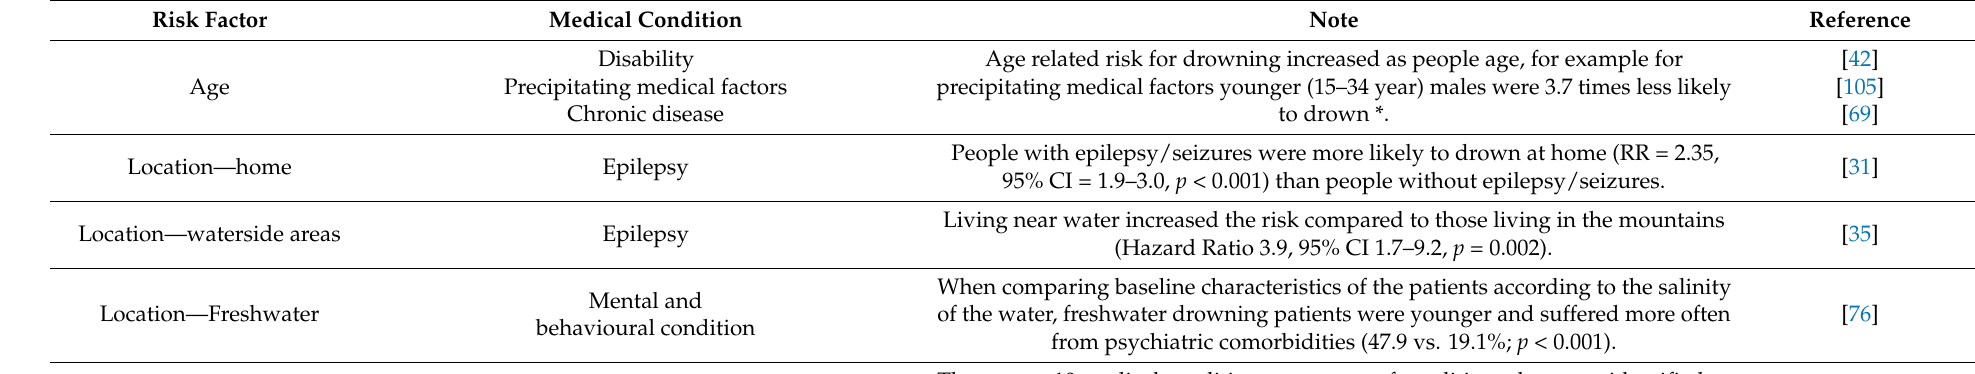
Table 7. Risk factors related to pre-existing medical conditions and